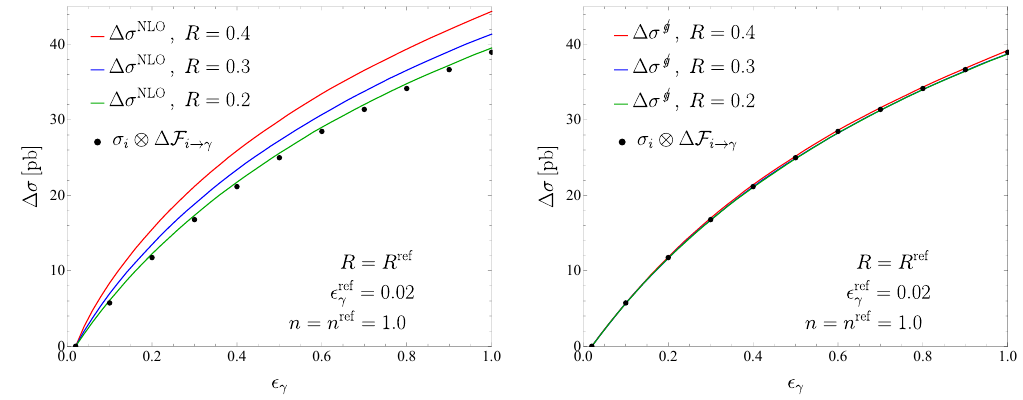
Figure 6 . Dependence of the cross section on (cid:15) γ for smooth-cone isolation (1.2). The lines labeled ∆ σ NLO show the difference of the full NLO cross sections. The dots represent ∆ σ = σ i ⊗ ∆ F i → γ computed with the fragmentation function according to (3.16) and are independent of R for R = R ref . For the lines labeled ∆ σ g/ in the right plot gluons inside the isolation cones were